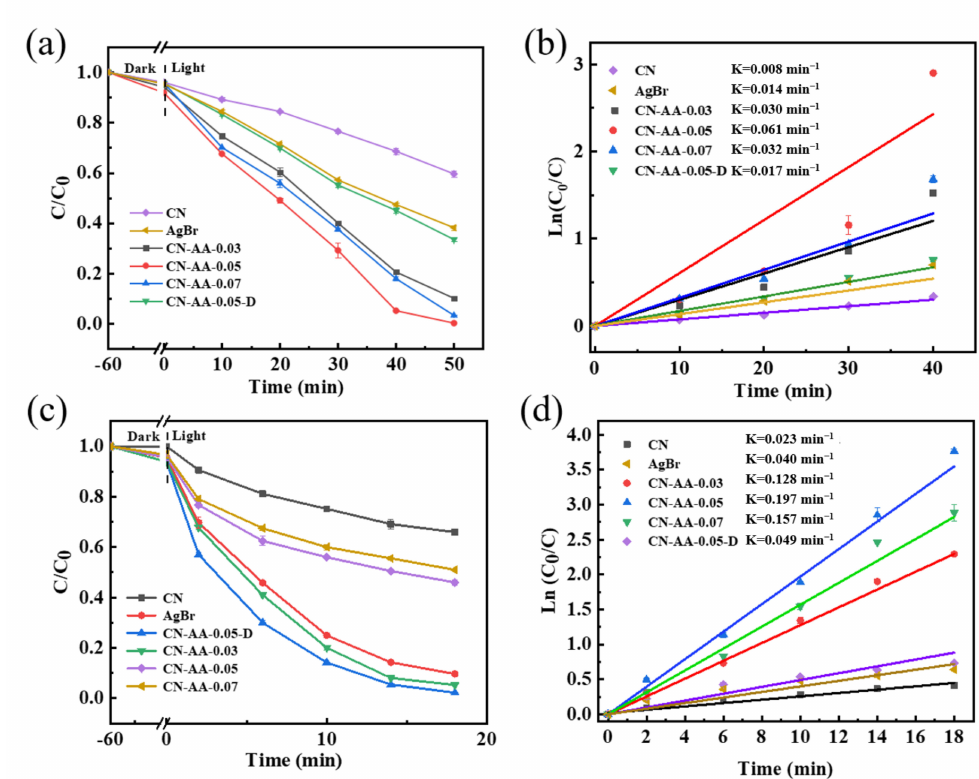
Figure 4. Photocatalytic ( a ) RhB and ( c ) MBT degradation activities of CN, AgBr, CN-AA-X (X = 0.03, 0.05, 0.07), and CN-AA-0.05-D. Kinetic curves of photocatalytic degradation of ( b ) RhB and ( d ) MBT by CN, AgBr, CN-AA-X (X = 0.03, 0.05, 0.07), and CN-AA-0.05-D.